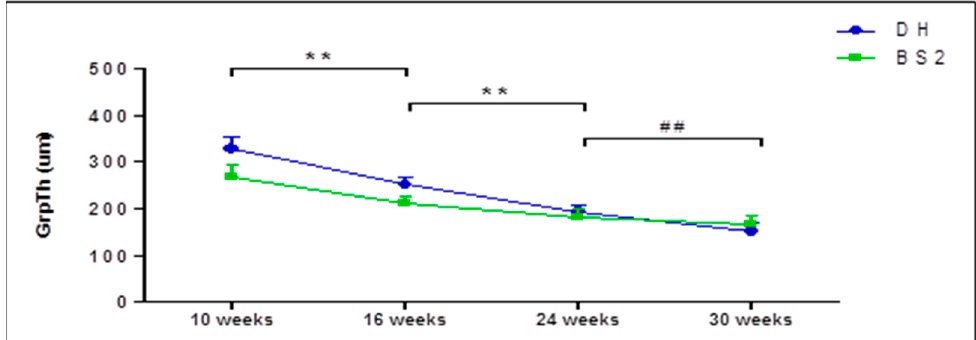
Figure 1. Growth plate thickness (GrpTh) of the proximal tibial epiphysis of DH and BS2 at four different time points. GrpTh was compared between the successive time points (Kruskal-Wallis test). A significant difference of p ≤ 0.01 in both strains was denoted as **, while p ≤ 0.01 only in DH was denoted as ## . Error bars represent the 95% CI.